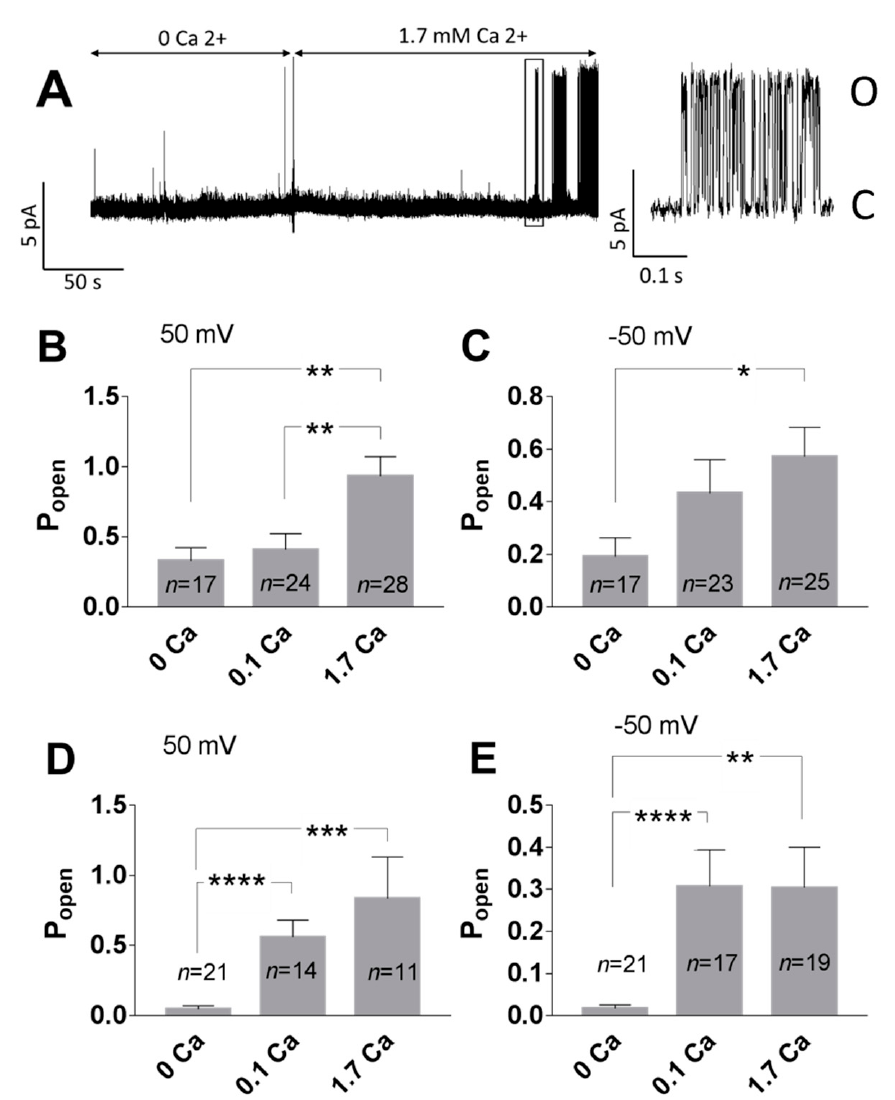
Figure 8. Ca 2+ increased the activity of TREK-2-like channels. ( A ) Example of the single-channel recording performed in the inside-out configuration. The bath solution without Ca 2+ was exchanged for a solution with 1.7 mM Ca 2+ . After 2–4 min of perfusion with Ca 2+ , the activity of the TREK-2-like channel was observed. The fragment indicated with the rectangle was elongated to show single openings of the channel. A low-pass filter of 0.5 kHz was applied. ( B , C ) P open in the cell-attached experiments; experiments with no TREK-2-like channel activity were excluded. Ca 2+ was applied in the extracellular bath solution. ( B ) 50 mV, ** p < 0.0085, Sidak’s multiple comparisons test; ( C ) − 50 mV, * p = 0.0495, Sidak’s multiple comparisons test. ( D , E ) P open in the inside-out experiments. Ca 2+ was applied to the cytoplasmic side of the membrane. ( D ) 50 mV, *** p = 0.0002, **** p < 0.0001, Dunn’s multiple comparisons test; ( E ) − 50 mV, **** p < 0.0001, ** p = 0.0017, Dunn’s multiple comparisons test.